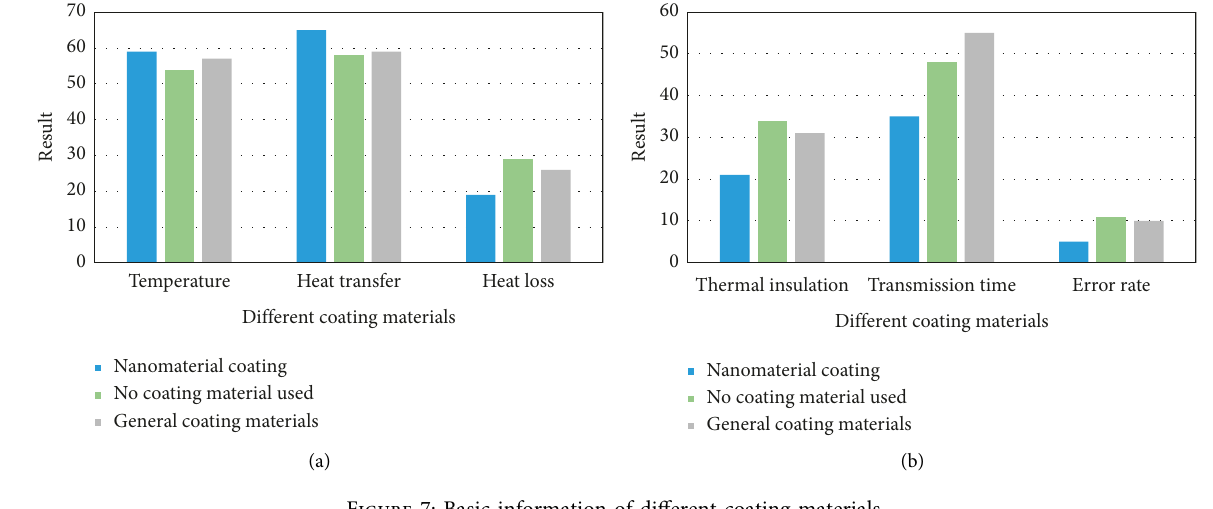
Figure 7: Basic information of different coating materials.